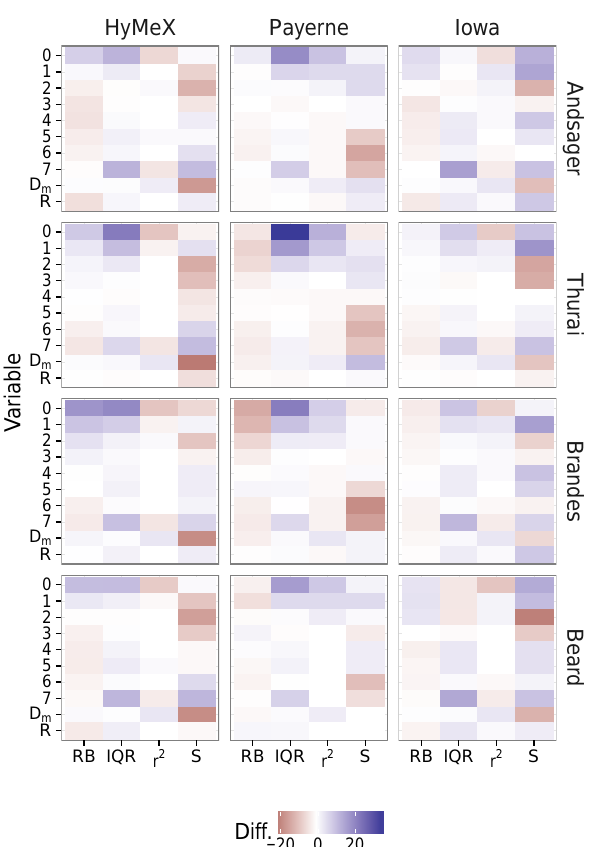
Figure 4. Differences in performance between the double-moment technique and SCOP-ME, using radar variables simulated from Par- sivel data, by region and drop axis ratio function (differences in Ta- bles A1, A2, and A3). Reds indicate negative differences, where the double-moment technique outperformed SCOP-ME. Variables are moment order n (mm n m − 3 ), D m (mm), and R (mmh − 1 ). Dif- ferences are shown for median relative bias (RB, %pts), IQR of relative bias (IQR, %pts), r 2 (difference in deviations from unity, multiplied by 100 for display on this scale), and regression slope ( S ; difference in deviations from unity, multiplied by